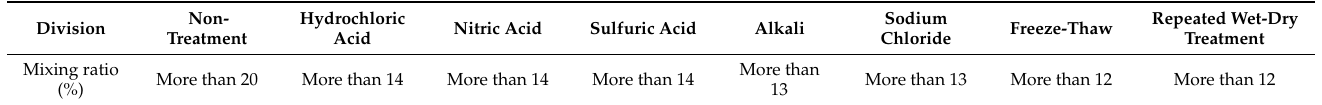
Table 9. The optimal superabsorbent polymer mixing ratio for water-expandable polyurethane to secure waterproofing performance according to deterioration